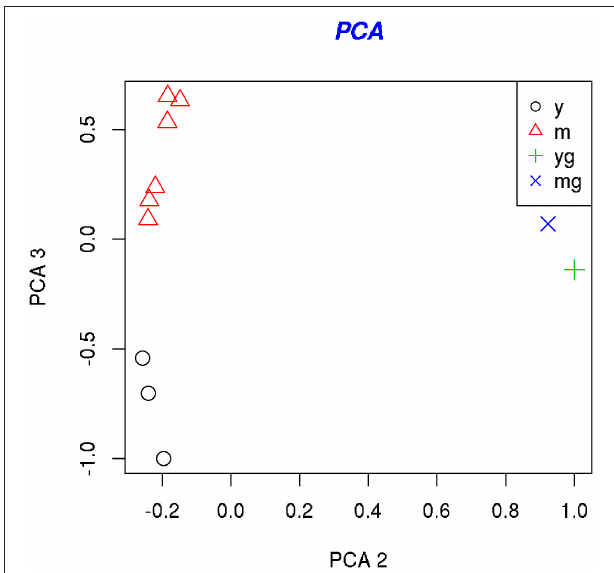
FIGURE 2 | PCA analysis of the samples. PCA-plots show the location of the samples along the first and second principle component (left) and along the second and third principle components (right). The second principal component separates young (5DIV) (yg) and mature (21DIV) (mg) glial cell samples from the neuronal samples, whereas the third principal component separates the young (5DIV) (y) and mature (21DIV) (m) neuronal samples.